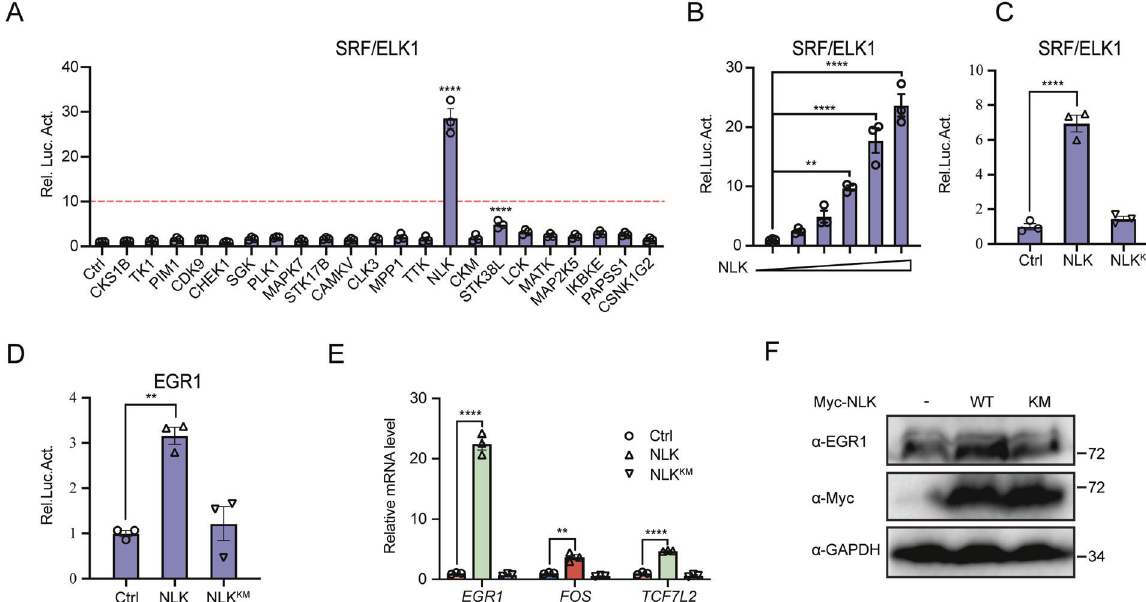
Fig. 1 NLK is a promoter of the SRF/ELK signaling pathway. A SRF/ELK pathway screening with a luciferase assay using a kinase library. SRF/ ELK reporter (100 ng) was cotransfected with the indicated kinase plasmids (400 ng) into HEK293T cells for 36 h, followed by analysis with a luciferase kit assay ( n = 2). B NLK promotes SRF/ELK signaling in a dose-dependent manner. SRF/ELK reporter (100 ng) was cotransfected with increasing concentrations of a Flag-NLK expression plasmid (0, 25, 50, 100, 200, or 400 ng) into HEK293T cells for 36 h, followed by analysis with a luciferase kit assay ( n = 3). C , D Effects of NLK or NLK KM on SRF/ELK ( C ) or EGR1 ( D ) luciferase reporter activity in HEK293T cells. The SRF/ ELK reporter (100 ng) or EGR1 reporter (100 ng) was cotransfected with an NLK or NLK KM plasmid (200 ng) into HEK293T cells for 36 h, followed by analysis with a luciferase kit assay ( n = 3). E Real-time PCR showing the effects of NLK or NLK KM plasmid (200 ng) on EGR1, FOS, and TCF7L2 gene transcription in HEK293T cells. The real-time PCR values were normalized to the GAPDH values ( n = 3). F Immunoblotting showing the effects of NLK or NLK KM on the protein level of EGR1 using the indicated antibodies in HEK293T cells. GAPDH was used as a loading control. Data are representative of three independent experiments and presented as the mean ± SEM. Statistical signi fi cance was analyzed by ANOVA (* p < 0.05, ** p < 0.01, *** p < 0.001, **** p < 0.0001). Ctrl control, NLK KM Mutation of lysine 167 to methionine. Source data ( A – F ) are provided as a source data fi